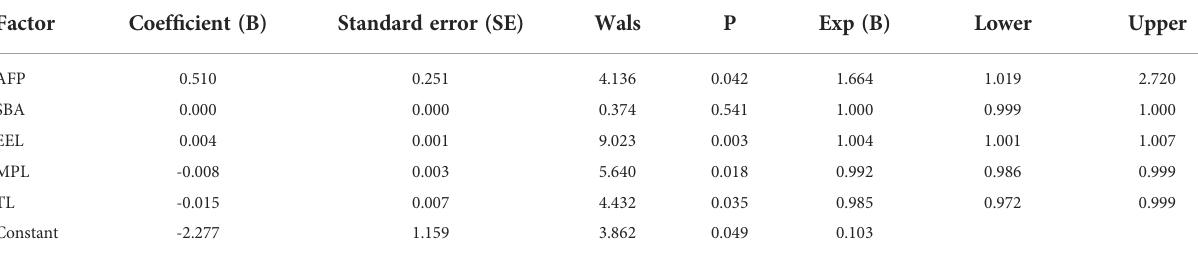
TABLE 2 Results of the developed binary logistic regression model in HCC and NC of